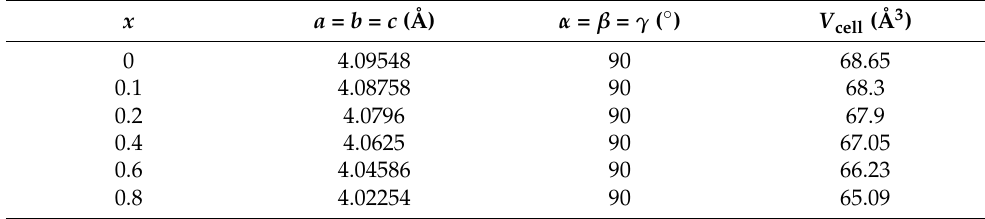
Table 1. Lattice parameters and unit cell volumes of Ba 1 − x Sr x (Zn 1/3 Nb 2/3 )O 3 ceramics.